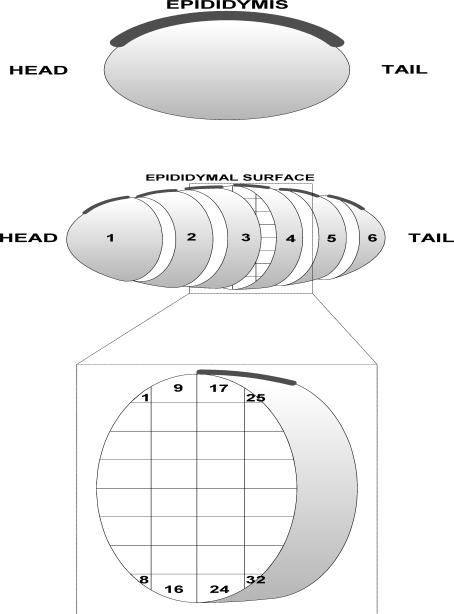
Testes Dissection StrategyTestes 374–1, 374–2, and 854–2. After slicing each testis in half, perpendicular to the epididymal axis, the two halves were each divided into three slices along the same axis for a total six slices. Each slice is then cut into 32 pieces and each piece is numbered (see inset for slice 3) to provide a binomial classification system (e.g., slice 3 piece 17). Note that there is some variation in slice and piece size because of the shape of the testis. This is reflected in the number of genomes per piece (see Table S1).